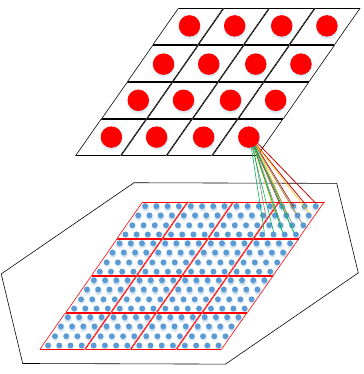
Figure 6. Hierarchical clustering